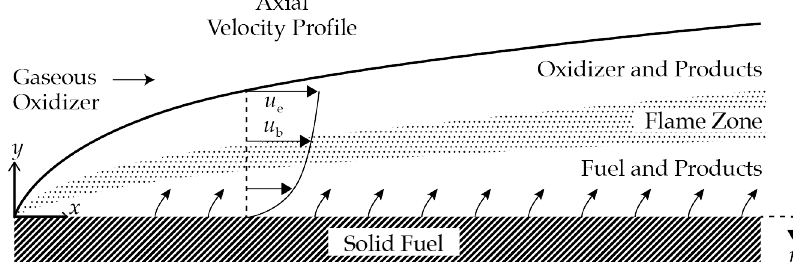
Figure 1. Illustrative sketch of the diffusion-limited combustion process in hybrid